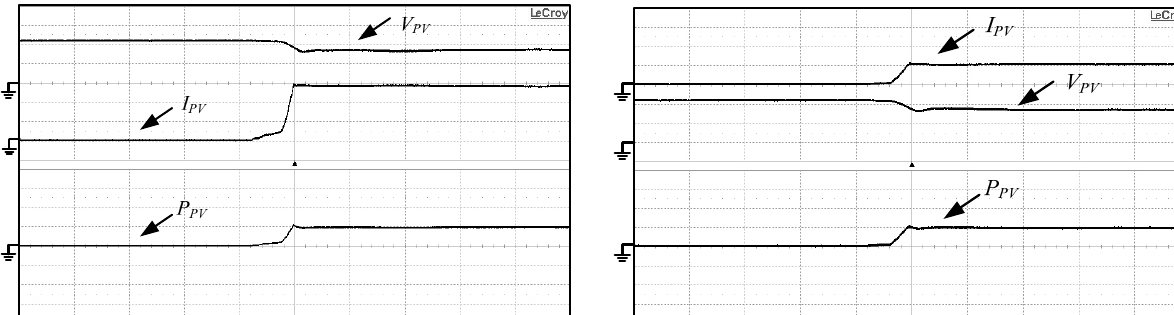
, current I and power P PV PV = 750 W. PV ( max )